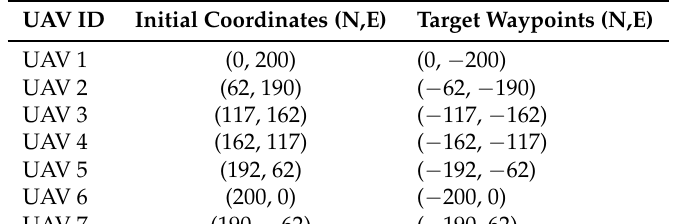
Table 6. Simulation of collision avoidance of MUAVS: Case 4.